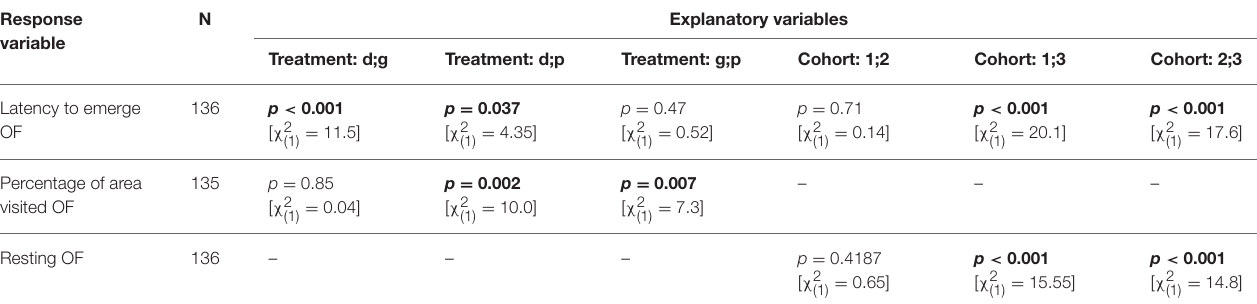
TABLE 4 | Model outputs (GEEs) testing for behavioral differences among treatments or cohorts in an open field test (first trial). Response variable